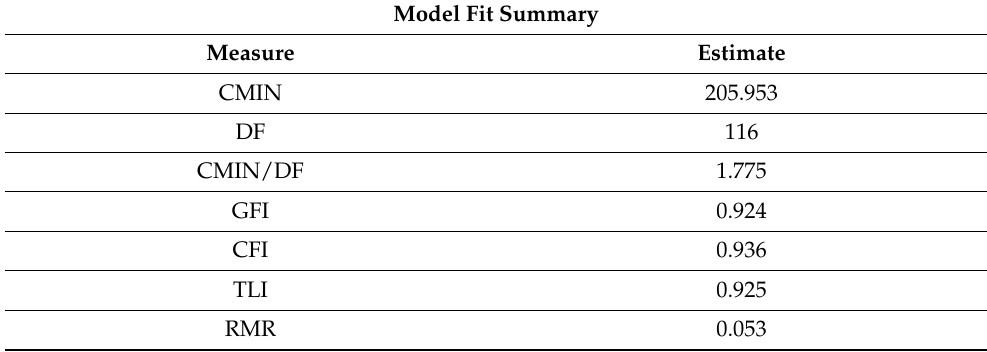
Table 5. The quality indicators of the